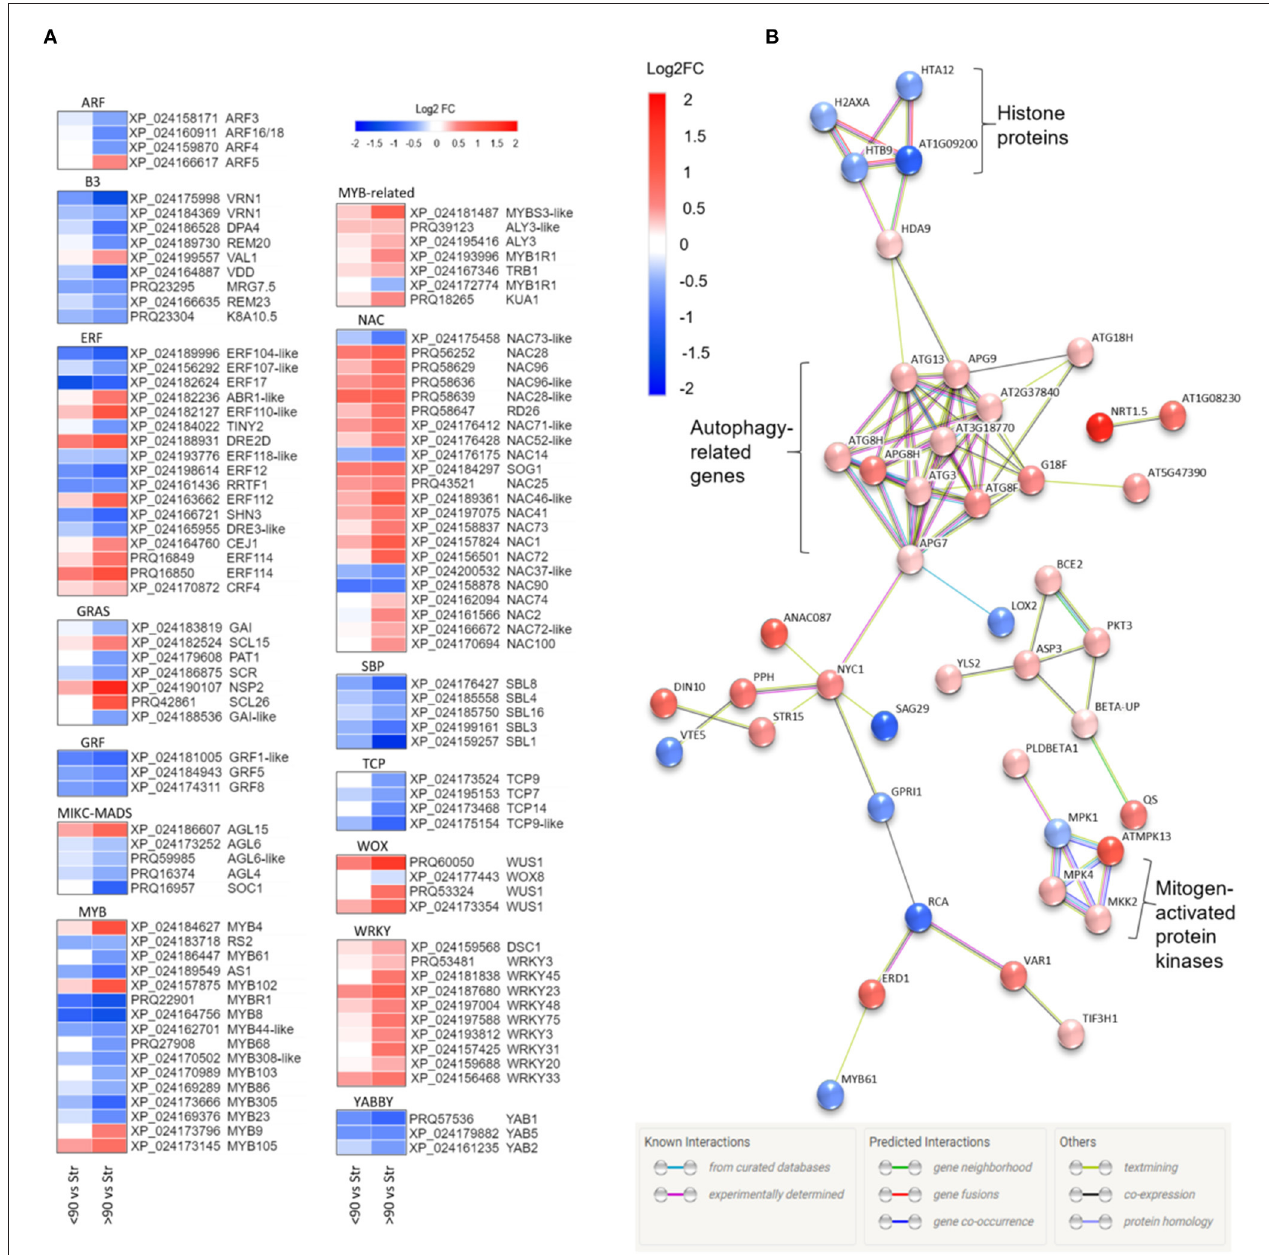
FIGURE 3 | (A) Heatmaps of differentially expressed transcription factor families showing Log 2 fold changes for each Rosa chinensis identifier. Up (red) and down (blue) log 2 fold changes are shown for < 90 ◦ and ≥ 90 ◦ in relation to straight (control) peduncles. For each data point, there is a significant difference in expression for at least one comparison group (i.e., < 90 ◦ vs, straight or ≥ 90 ◦ vs, straight). Heatmaps were generated using Morpheus (Morpheus, https://software.broadinstitute. org/morpheus). (B) Protein interactions amongst senescence-related genes differentially expressed in ≥ 90 ◦ compared to straight rose peduncles, identified using STRING. Red and blue scales indicate up- and downregulated expression (Log 2 FC; p adjust. < 0.05).